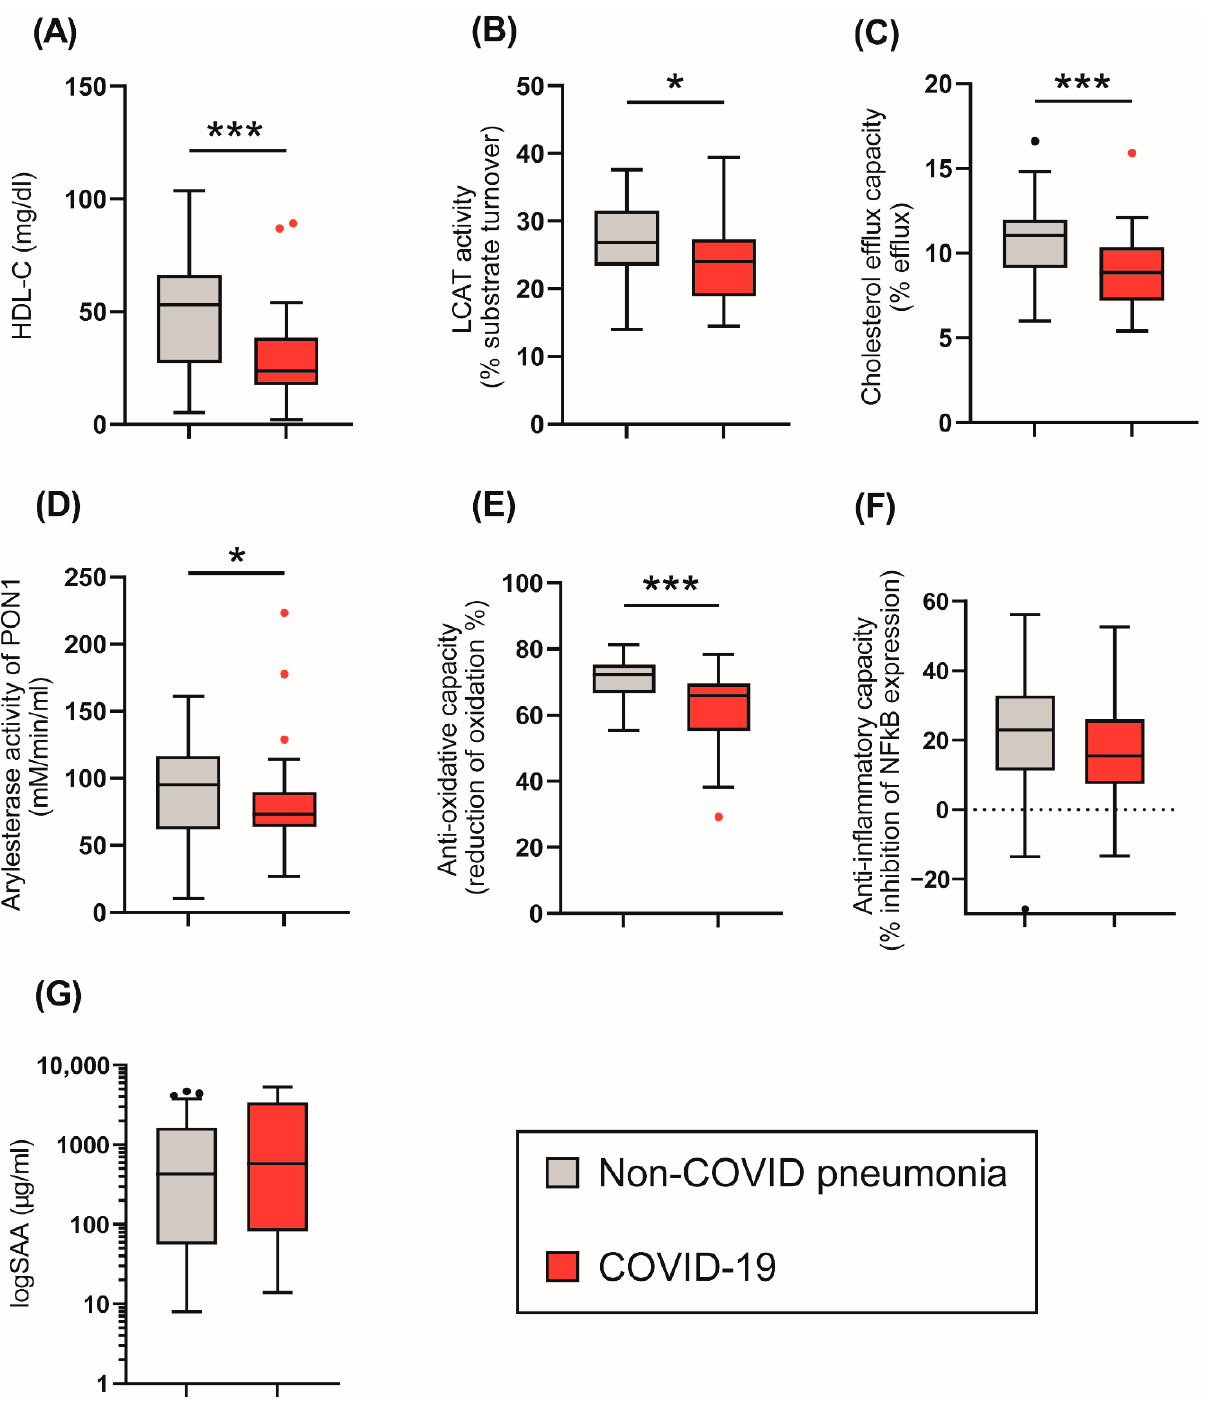
Figure 1. Tukey boxplots of HDL-related parameters in the COVID-19 ( n = 48) and control cohort ( n = 32) at baseline. ( A ) HDL-cholesterol levels (mg/l); ( B ) LCAT activity (% substrate turnover); ( C ) Cholesterol efflux capacity (%); ( D ) arylesterase activity of PON1 (mM/min/mL serum); ( E ) anti-oxidative capacity (% reduction of oxidation); ( F ) anti-inflammatory capacity (% inhibition of NF κ B expression); ( G ) logSAA ( μ g/mL). Differences between the two groups were analyzed by Mann–Whitney U test. Outliers are represented by black and red dots. * p < 0. 05, *** p < 0.001.